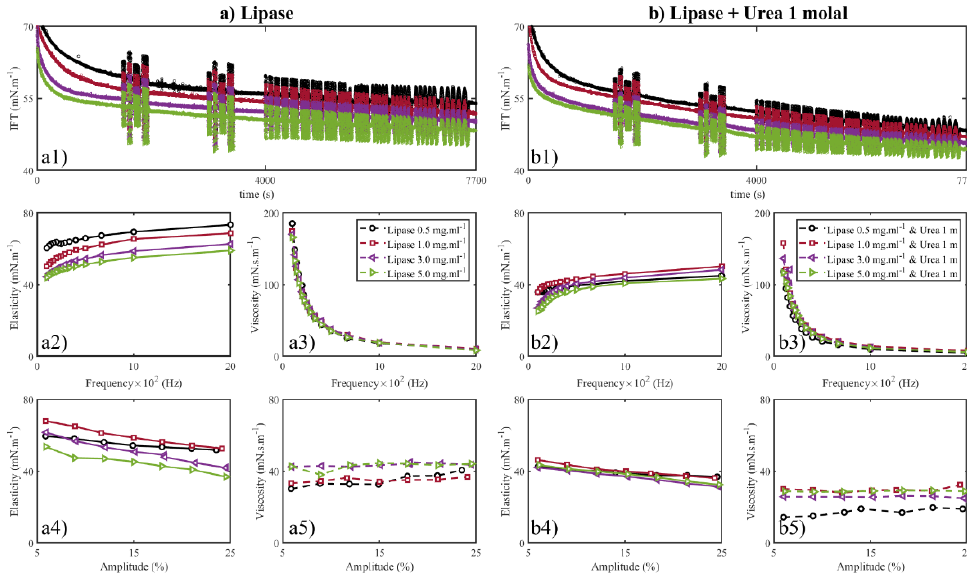
Figure 10. Effect of lipase concentration on the interfacial tension and viscoelasticity of the adsorbed layer at the air–water interfaces: ( a ) pure lipase and ( b ) lipase and 1 molal urea mixtures; ( a1 ) dynamic interfacial tension of adsorbed layers from lipase solutions of 0.5, 1.0, 3.0, 5.0 mg · mL − 1 over time; ( b1 ) dynamic interfacial tension of adsorbed layers from lipase solutions of 0.5, 1.0, 3.0, 5.0 mg · mL − 1 and urea 1 molal over time; ( a2 , a3 , b2 , b3 ) effect of the interfacial oscillation frequency on the viscoelastic moduli of the interface; ( a4 , a5 , b4 , b5 ) effect of the interfacial oscillation amplitude on the viscoelastic moduli of the interface; the solid and dashed lines are drawn as a guide for the eye.